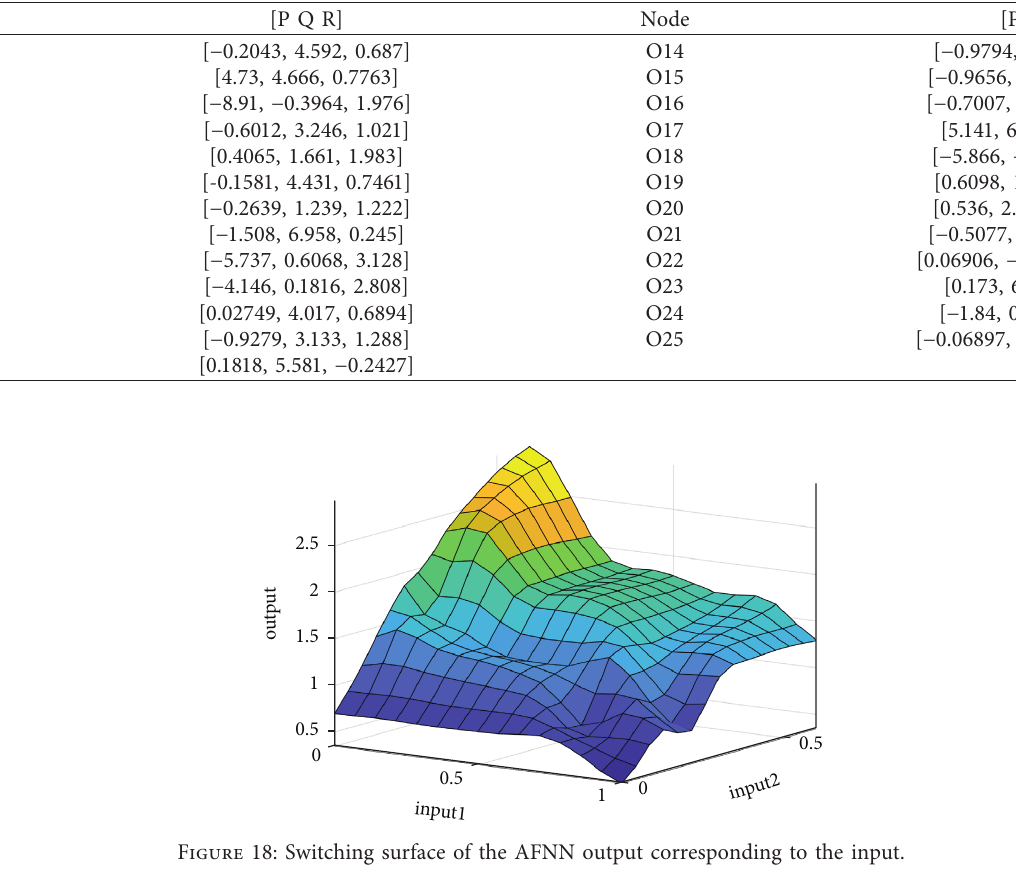
Table 6: Output node.